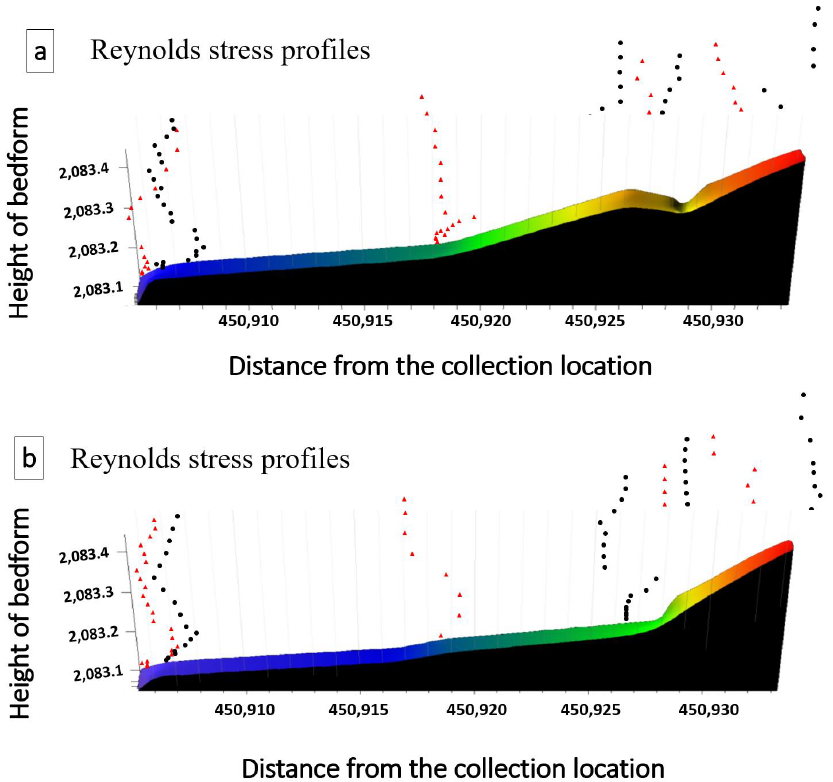
Figure 7. Nondimensional Reynolds stress profiles ( −UʹWʹ of the left bank of the river, and ( b ) the central axis of the river.